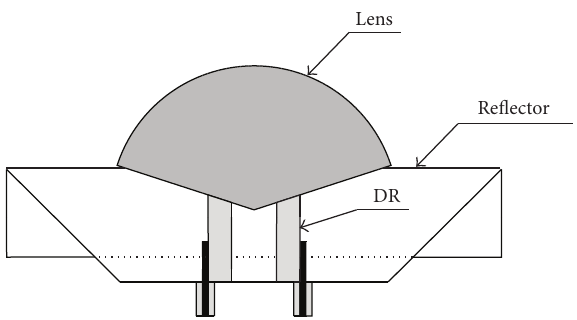
Figure 50: Geometry of the high-gain mushroom-shaped dielectric resonator antenna in the vertical symmetry plane of the antenna [185]. The DR, the lens, the reflector, and two of the four coaxial probes useful to excite the circular polarization are reported in the